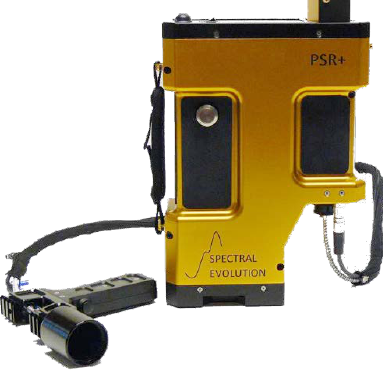
Figure 4. The PSR + 3500 Spectroradiometer was used to collect reflectance Figure 4. The PSR+ 3500 Spectroradiometer was used to collect reflectance data.